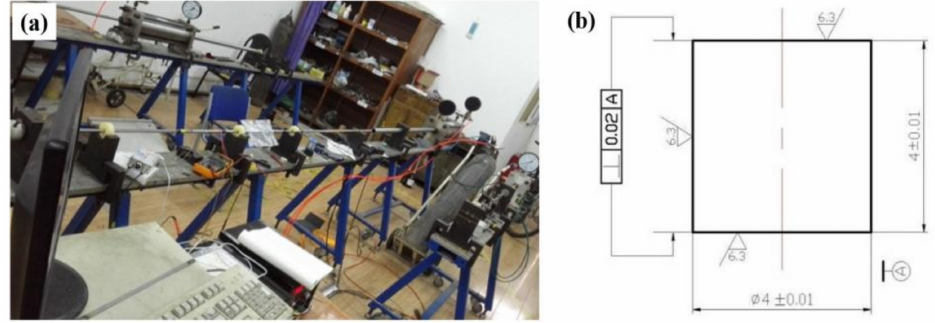
Figure 1. The split Hopkinson pressure equipment in ( a ) and the corresponding dimension of the sample used for dynamic performance tests in ( b